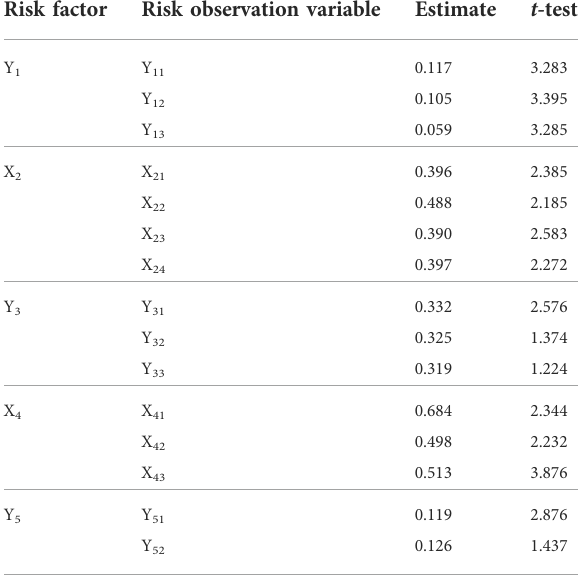
TABLE 3 Parameter estimates and reliability of model operation results (Source: calculated according to Amos software). Risk factor